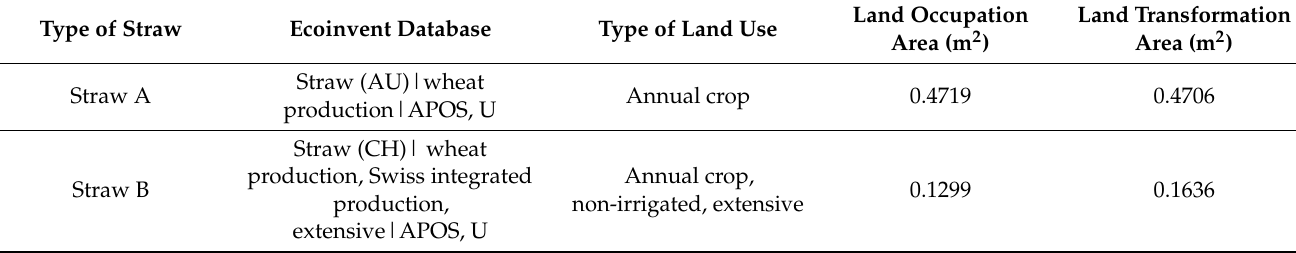
Table 4. Straw databases used for straw environmental contribution comparison. Land occupation described the duration of land use from soil cultivation until harvest and the yield per area unit in a year. Land transformation referred to the area required to produce 1 kg of